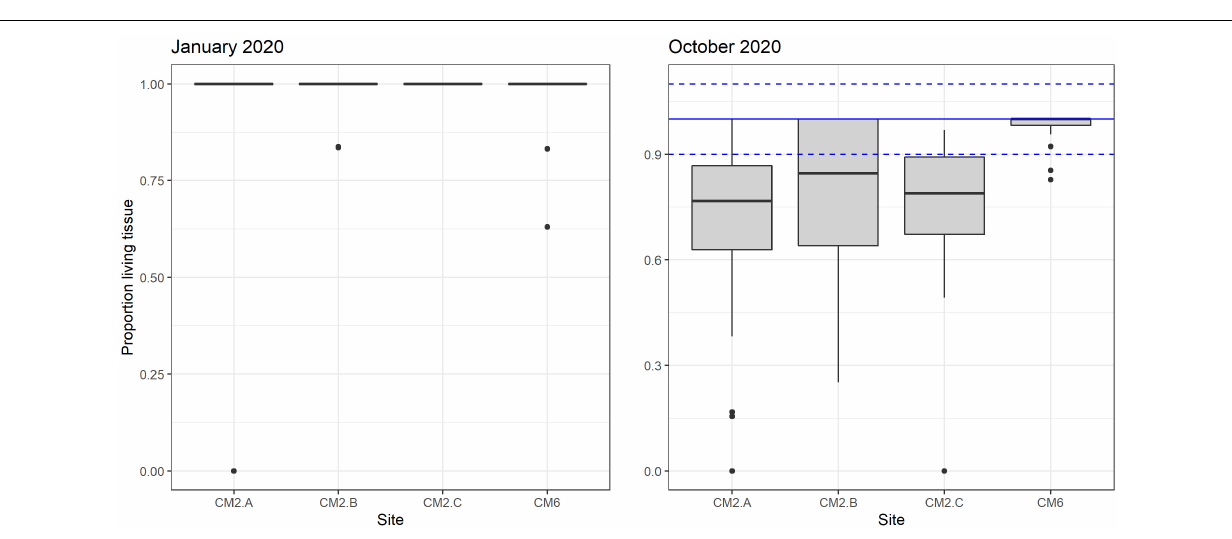
FIGURE 7 | Proportion of living tissue box plot remaining on corals outplanted across sites between January and October